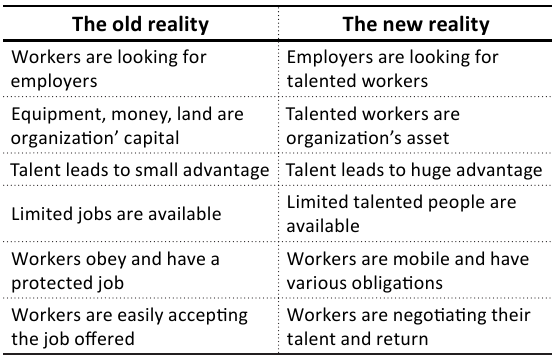
Table 2. Comparison of different priorities in the past and